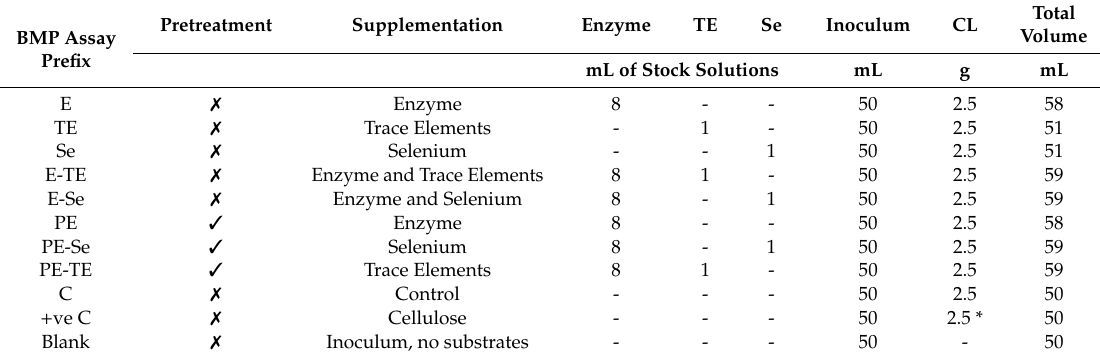
Table 2. Description and composition of individual BMP